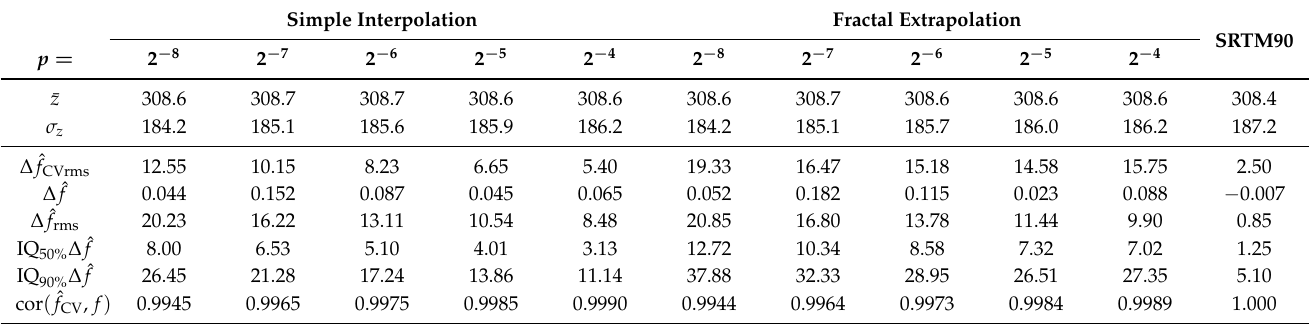
Table 1. K -fold and other statistics of interpolated DEM using simulated data extracted from SRTM at randomly distributed points ( p denotes point density per pixel). MMI was applied without and with fractal extrapolation. The SRTM90 column contains an assessment of SRTM resampling error based on the original 30 m resolution SRTM (using K -fold cross-validation) for comparison. Values are in meters.